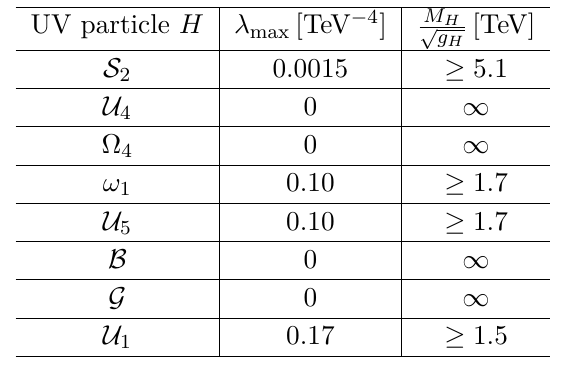
Table 9 . Lower bounds on the UV states assuming the UV model contains only the U 1 particle, assuming M U = 2 TeV and g U = 1 1 1